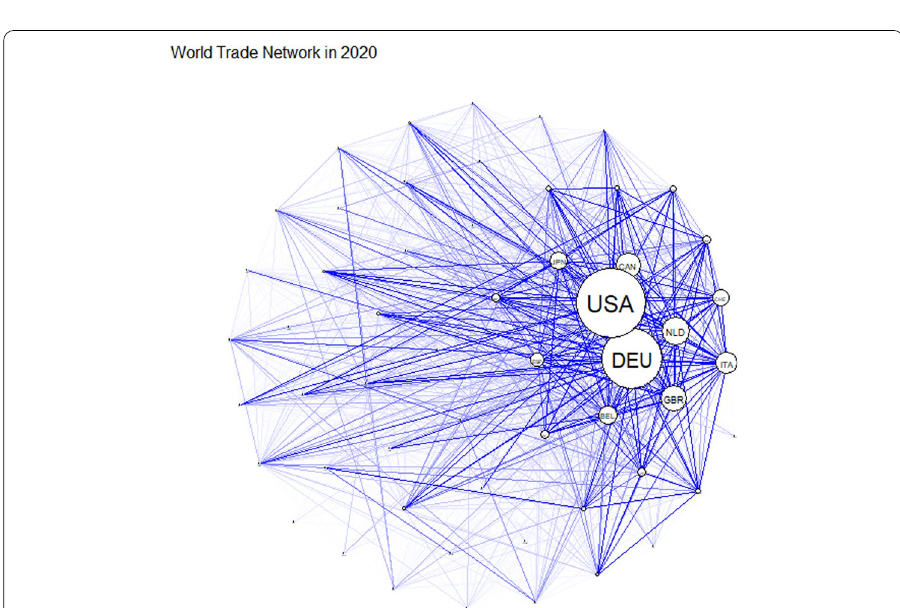
Fig. 9 WTN representation in 2020. The size of the nodes is proportional of its